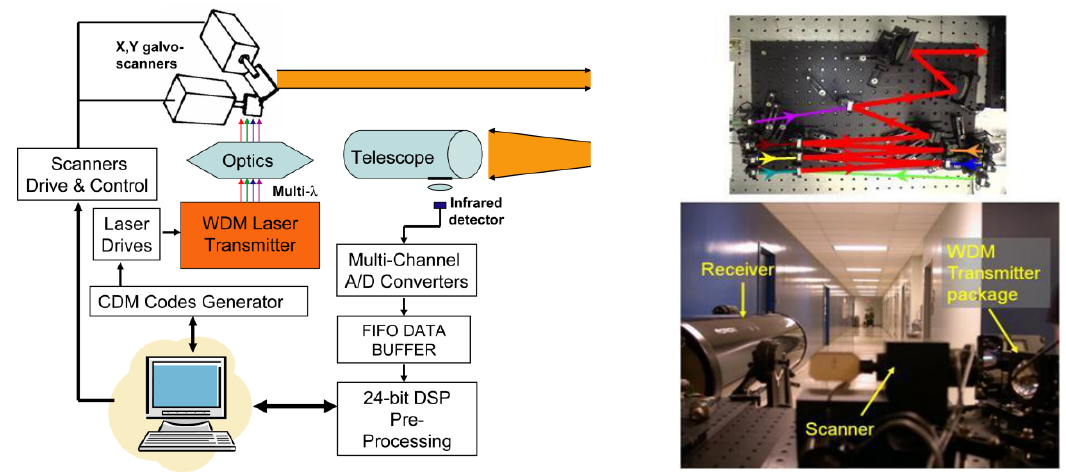
Figure 4. Left: block diagram of the multi-spectral laser imaging system. Right-top: wavelength-division multiplexed transmitter for vis-near-IR diode lasers. Right-bottom: mid-IR